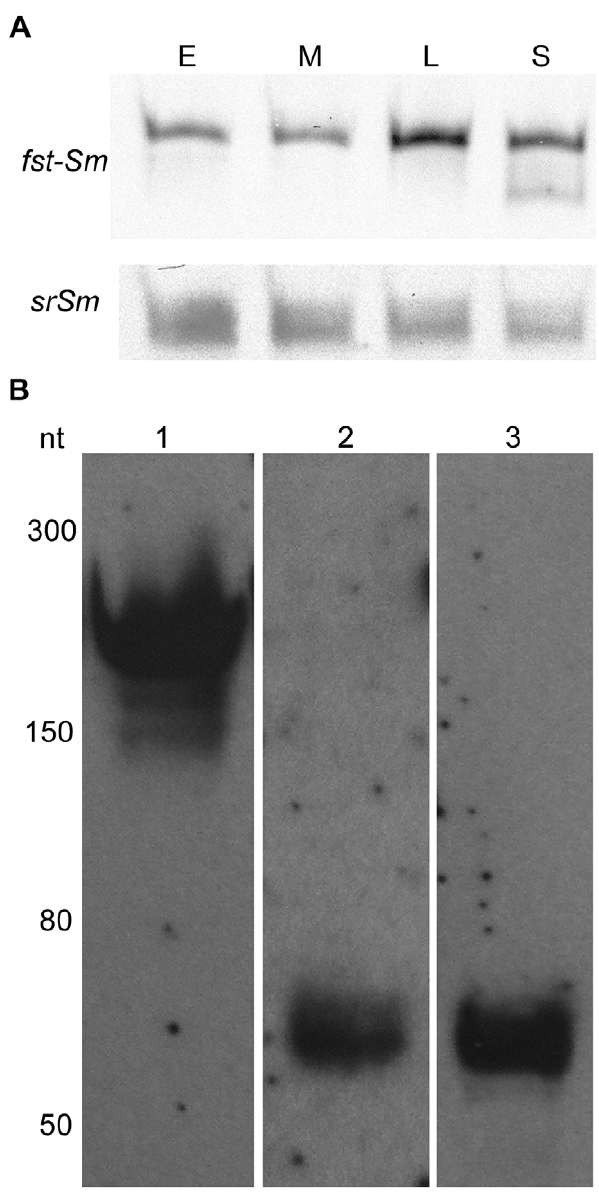
Figure 2. Detection of RNAs in IGR176 by Northern blot analysis using biotin-labeled DNA probes. Total RNA from S. mutans WT strain was resolved on a 12% polyacrylamide denaturing gel containing 8 M urea. ( A ) Total RNA was extracted from UA159 WT cells during the early log (E), mid-log (M), late log (L), and stationary (S) phase of growth. The blot of fst-Sm was probed with a PCR-amplified double- stranded DNA that corresponds to the full-length coding region, while the blot of srSm was probed with CMT-558 DNA oligoprobe. The blots shown are representative of three independent experiments. ( B ) Total RNA isolated from UA159 WT cells grown to mid-log phase. fst-Sm mRNA was detected with a PCR-amplified double-stranded DNA that corresponds to the full-length coding region (lane 1). Oligoprobes CMT- 558 (lane 2) and CMT-572 (lane 3) corresponding to the 5 9 and 3 9 UTR of srSm , respectively, were used to detect the srSm RNA. Low Range ssRNA Ladder (New England Biolabs) are indicated in nucleotides on the left.